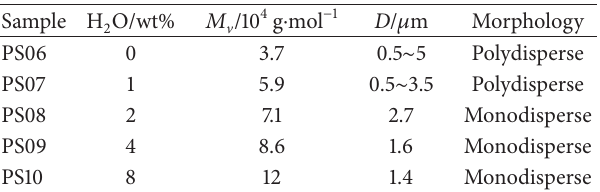
Table 3: Effect of water in blend solvent on the polystyrene micros-